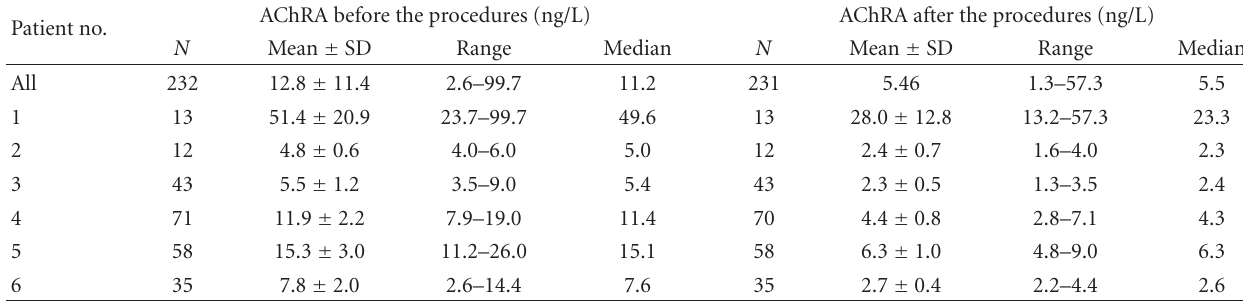
Table 2: AChRA levels. N = number of patients. Normal AChRA values in our laboratory: 0.00–0.40 nmol/L. Patient no.